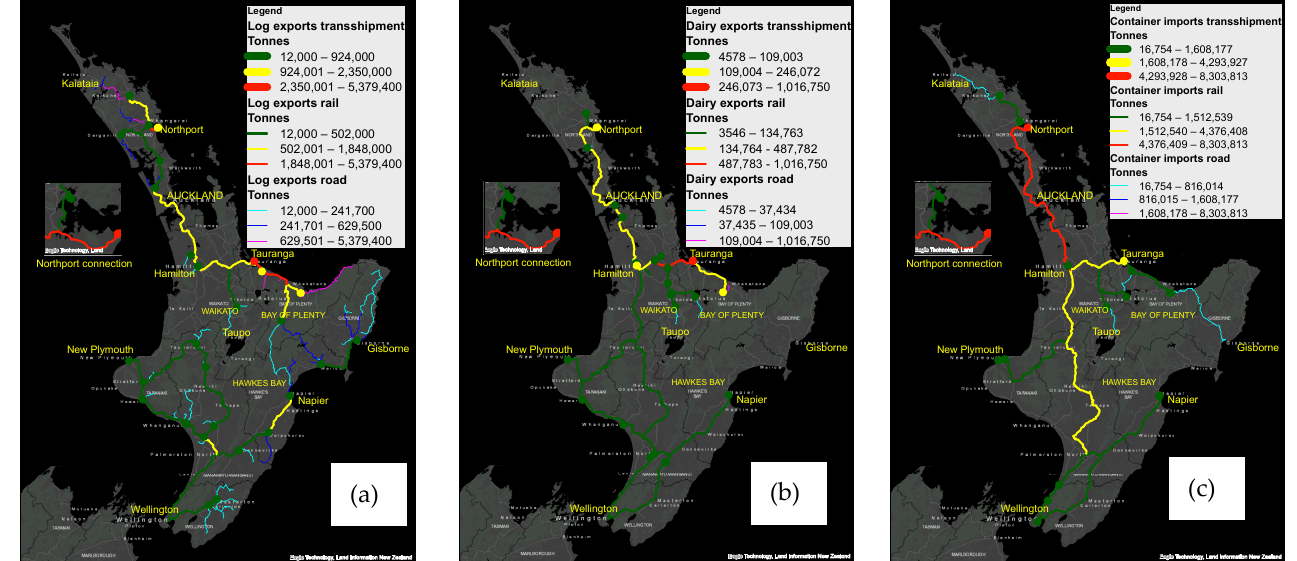
Figure 9. Network traffic through different modes, energy as a cost attribute: ( a ) log exports under FS-WC-E; ( b ) dairy exports under FS-WC-E; ( c ) container imports under FS-WC-E.